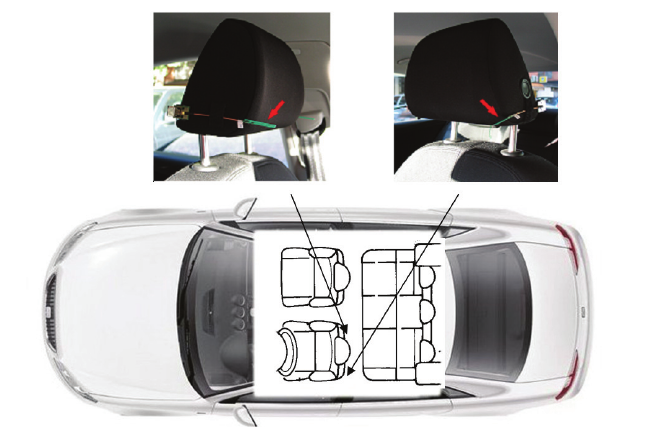
Figure 6. Antennae location within the